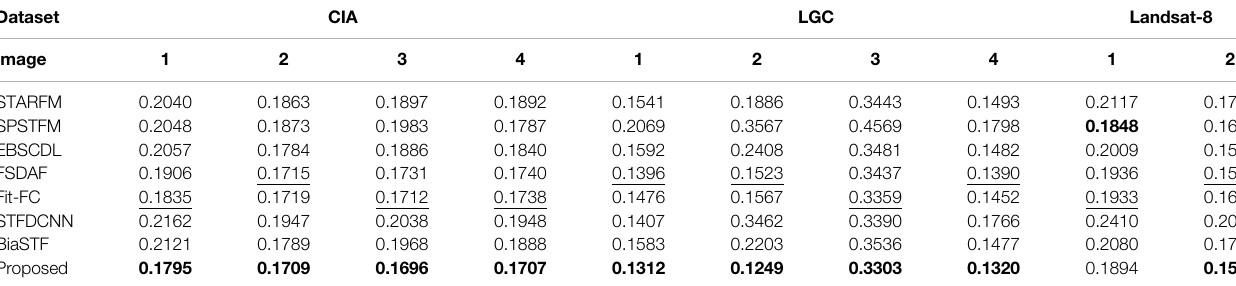
TABLE 9 | ERGAS evaluation of spectral inconsistency. Dataset